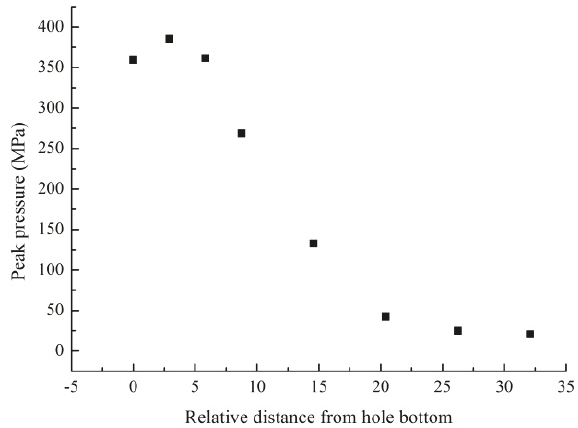
Figure 8: Variation in initial borehole wall pressure with relative distances from hole bottom (middle air-decked charging